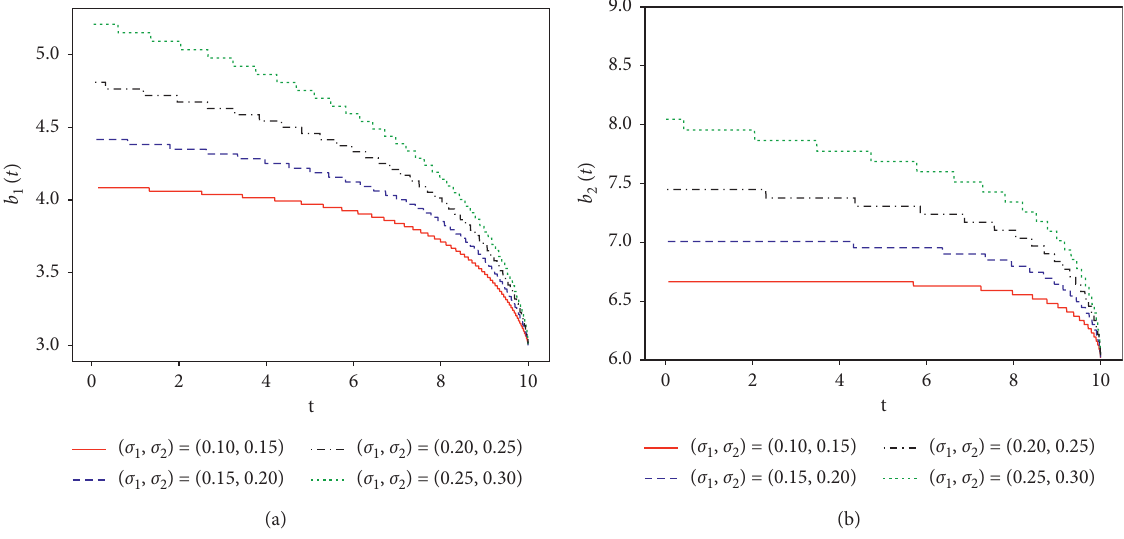
Figure 5: The impact of varying volatility on the early exercise boundary for (A.) regime 1 and (B.) regime